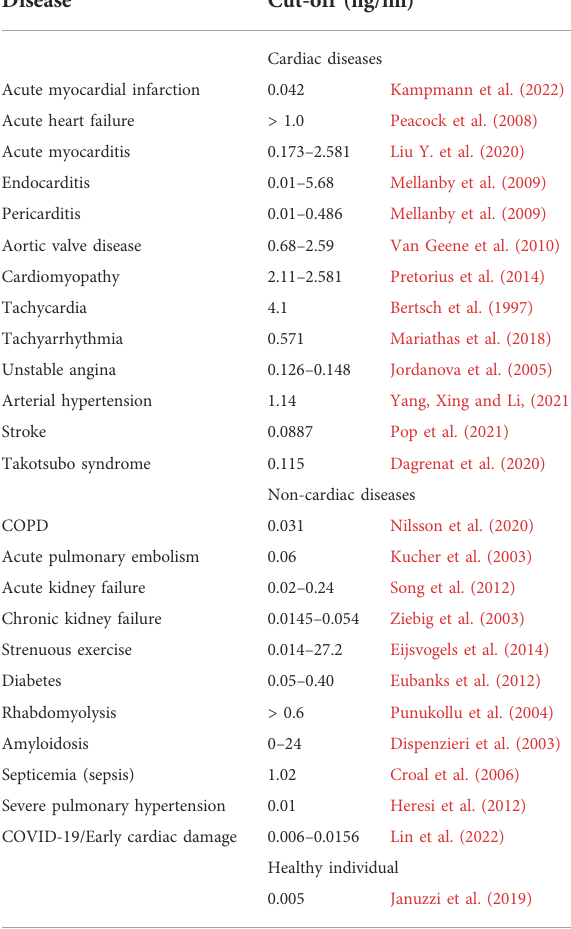
TABLE 2 cTnI cut-off values for the cardiac and non-cardiac diseases presented in Table 1.